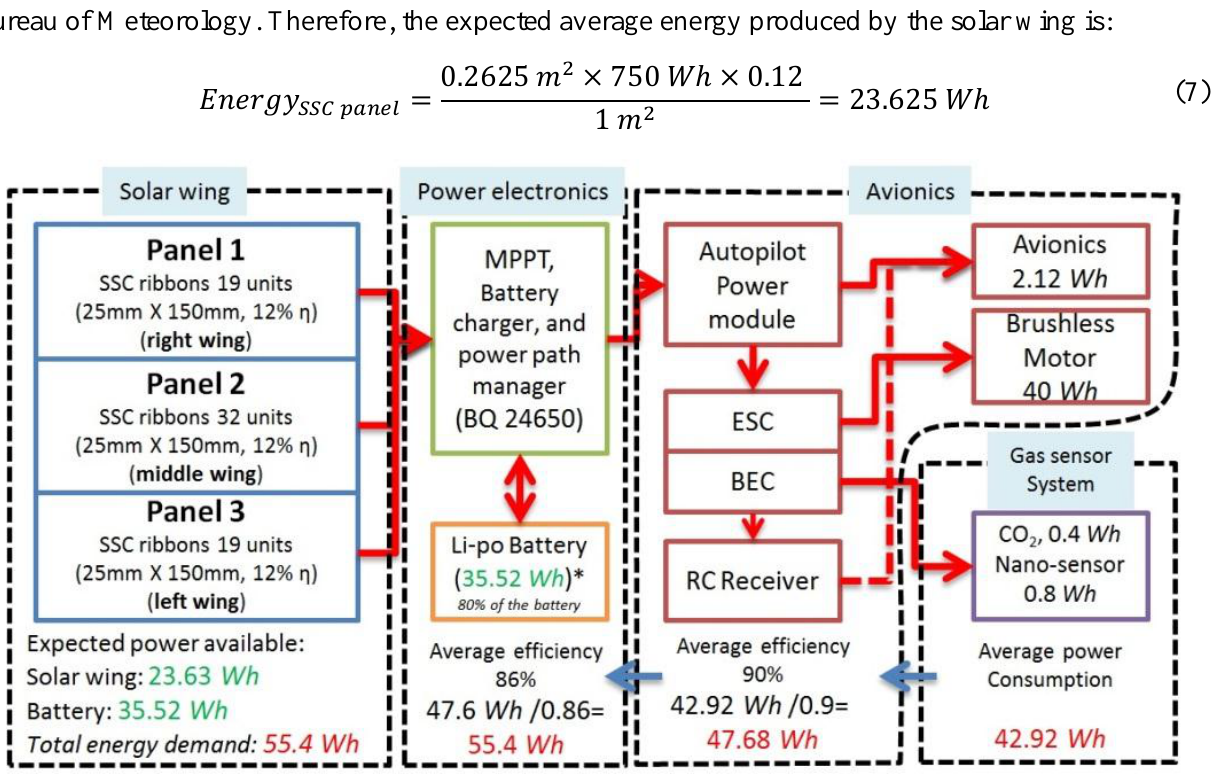
Figure 12. Energy demand and the energy available in the